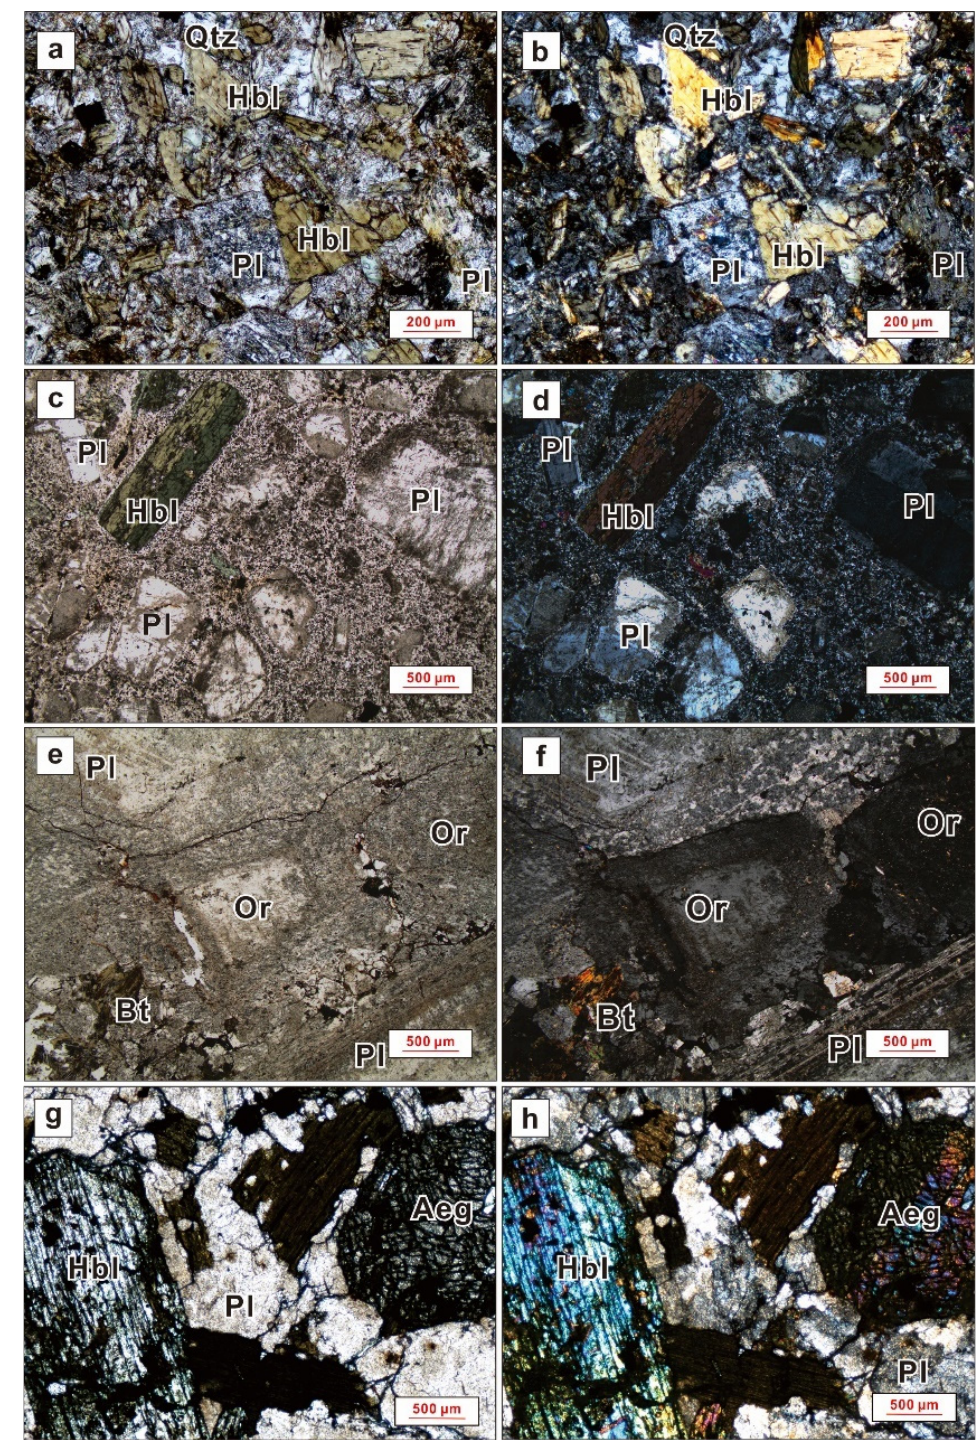
Figure 3. Photomicrographs showing characteristics of alkaline complex from Longbaoshan area. ( a , b ) Hornblende diorite. ( c , d ) Hornblende syenite porphyry. ( e , f ) Biotite monzonite porphyry. ( g , h ) Aegirine diorite porphyrite. Pl—plagioclase; Or—orthoclase; Hbl—hornblende; Qtz—quartz; Aeg—Aegirine pyroxene. The left column includes crossed-polarized light photomicrographs and the right column includes plane-polarized light photomicrographs.